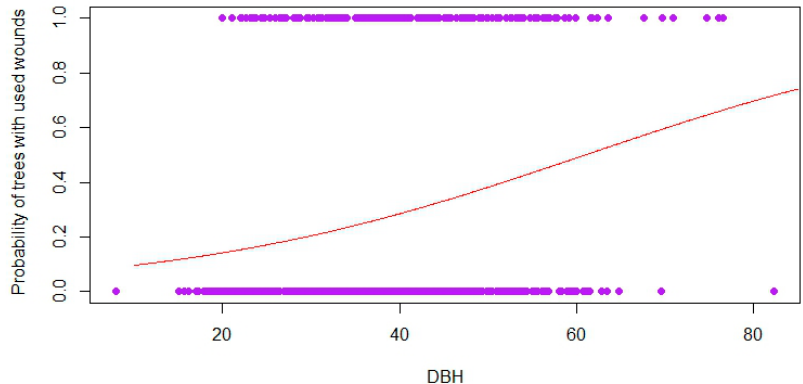
Figure 10. Correlation showing the relationship between diameter at breast height (DBH) and the probability of trees having used wounds (209 trees) out of the total wounded trees (667 trees; p -value = 1.34 × 10 − 6 ; field measurements).